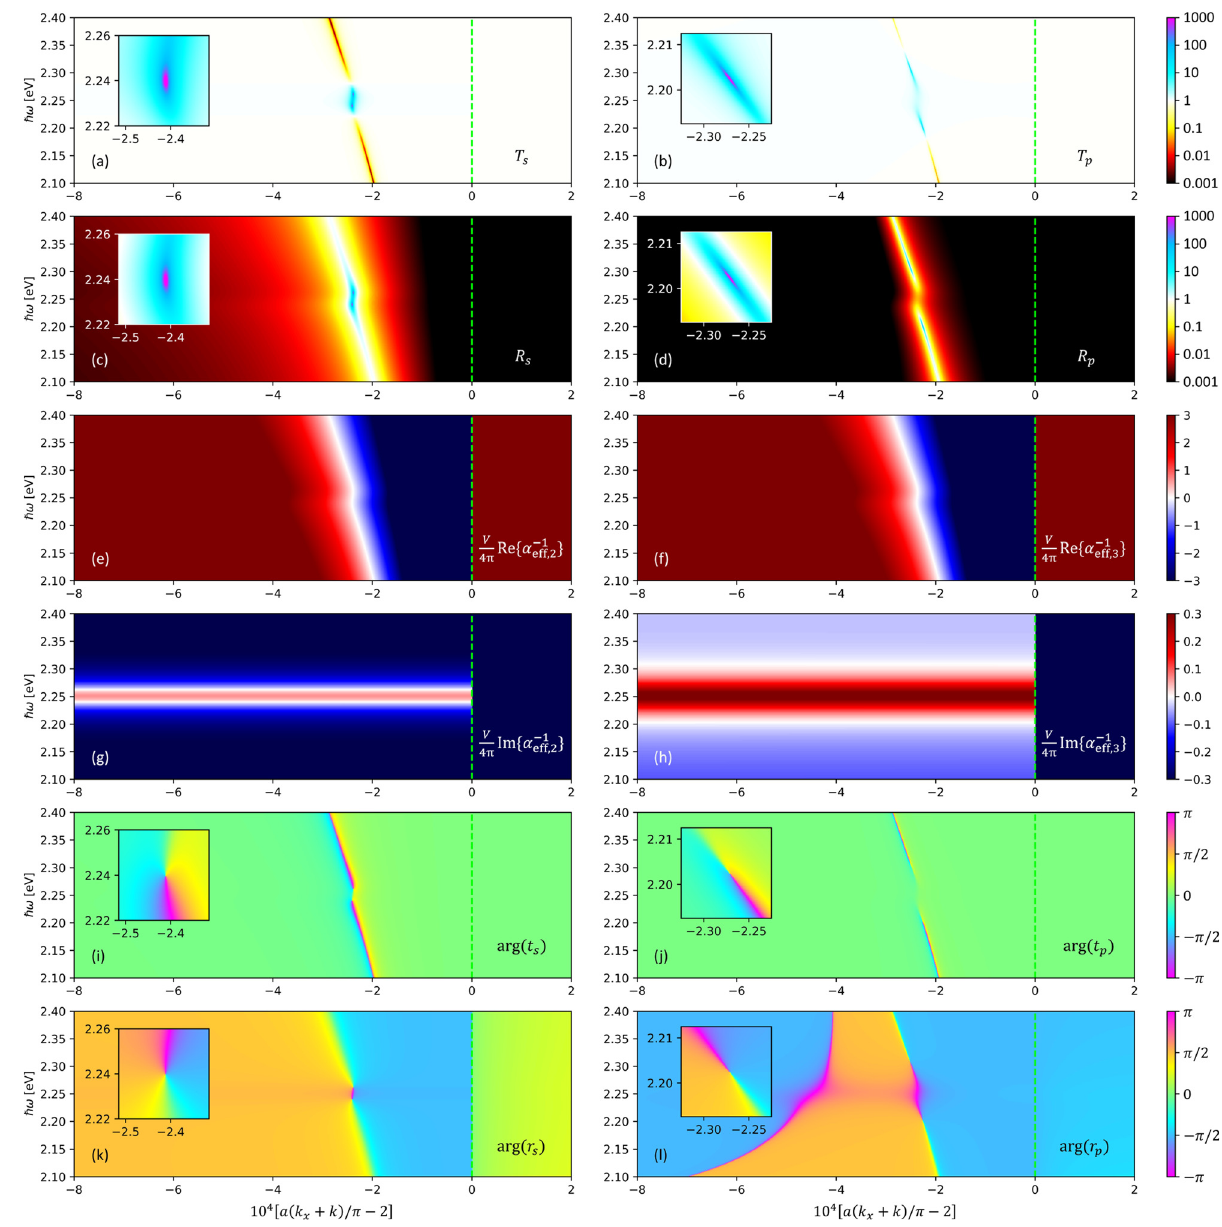
Figure 4: Magnification of Figure 3, with the momentum axis corrected to match with the (1, 0)-Rayleigh anomaly, which now appears vertical and is marked by the green dashed